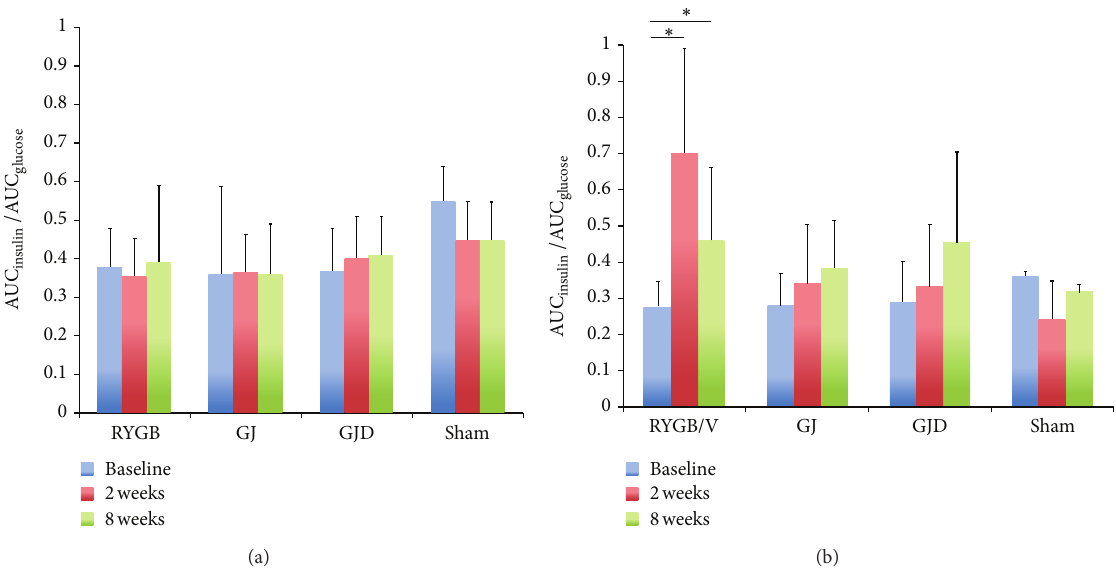
Figure 3: (a) IVGTT AUC /AUC . Pre- and postoperative IVGTT AUC insulin glucose /AUC . Pre- and postoperative MTT AUC (b) MTT AUC insulin glucose statistical significance ( 𝑃 < 0.05